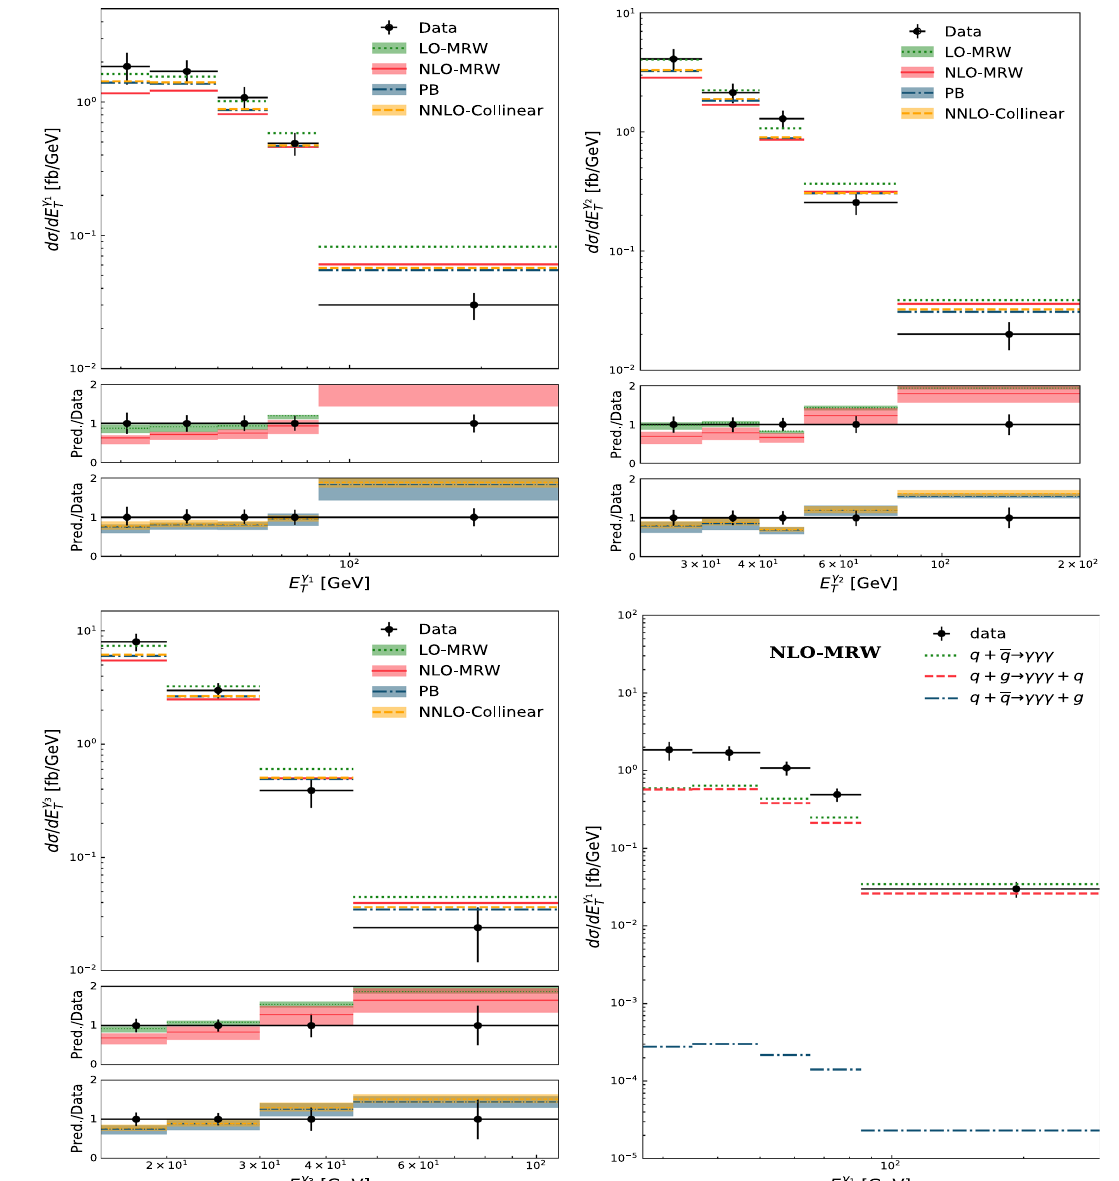
Fig. 6 In the top panel of each plot the differential cross sections for different UPDF models and also NNLO collinear with respect to E γ 2 γ 3 E and E are shown and compared to the ATLAS experimental data T T [1] as denoted in each figure. In the two bottom panels in each plot,